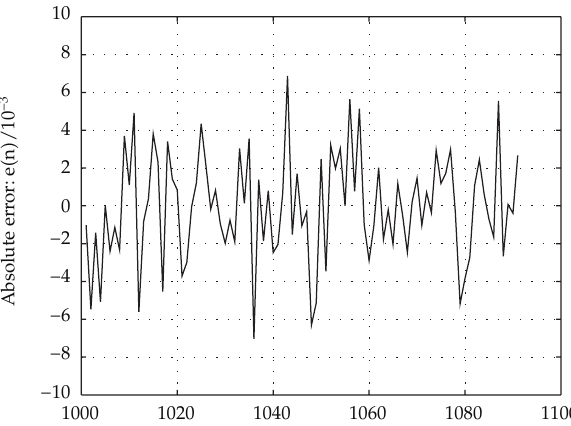
Figure 5: Absolute error of one-step prediction (cid:4) 500 fitting data (cid:5)